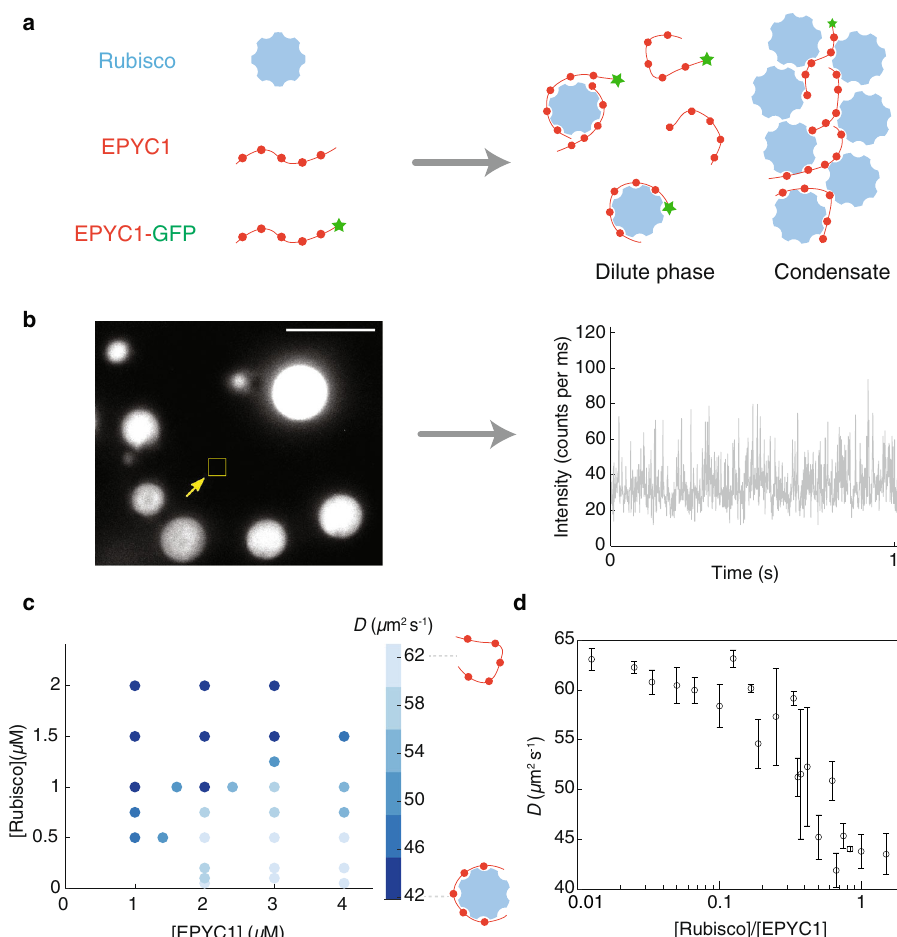
Fig. 3 EPYC1 and Rubisco form complexes in the dilute phase of a phase-separated system. a Cartoon depicting EPYC1 and Rubisco complexes in the dilute phase alongside a condensate. b FCS was performed in a focal volume away from condensates to measure the diffusion rate of EPYC1-GFP in the dilute phase. The EPYC1-GFP concentration was fi xed at 20 nM. Left image represents typical fi eld of view (bulk concentrations: [EPYC1] = 4 μ M, [Rubisco] = 0.75 μ M), scale bar = 5 μ m. Right image is a representative fl uorescence intensity time trace in the dilute phase. c Diffusion coef fi cients ( D ) of EPYC1-GFP in the dilute phase in the presence of condensates obtained by FCS. Obtained D values are color coded as shades of blue (lighter blue represents higher D ) and plotted on the phase diagram of Rubisco and EPYC1 concentrations. D values are the average values of 3 repeat experiments. d The diffusion coef fi cients ( D ) in c plotted against overall Rubisco/EPYC1 concentration ratio. Error bars are standard deviations of repeated experiments. Note that because the x -axis is the [Rubisco]/[EPYC1] ratio, in some cases different data points in c are clustered into one data point in d (for example, D values of 1 µ M Rubisco with 2 µ M EPYC1 and 0.5 µ M Rubisco with 1 µ M EPYC1 are summarized into one data point where the [Rubisco]/[EPYC1] ratio is 0.5). Concentrations are expressed in terms of Rubisco holoenzymes and